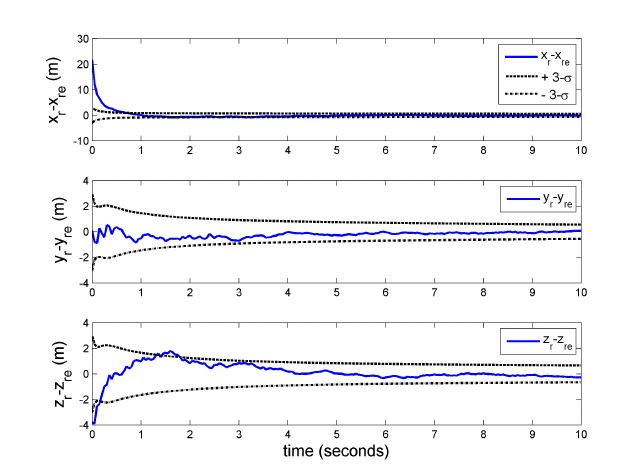
Figure 12. Position tracking errors (true-estimated) with 3 − σ bounds for target UAV (Case 1C).